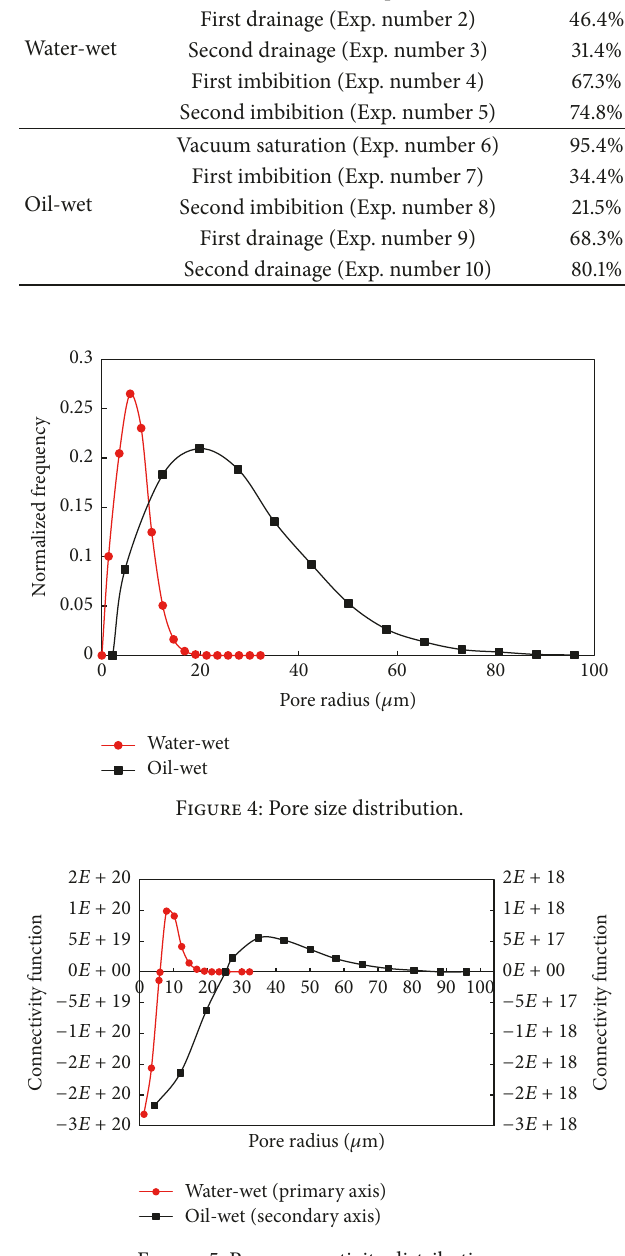
Figure 5: Pore connectivity